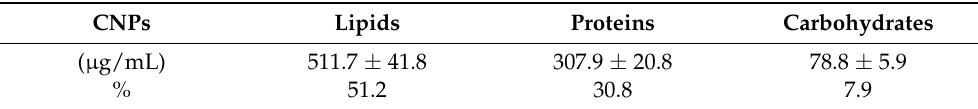
Table 2. Major compositions of the